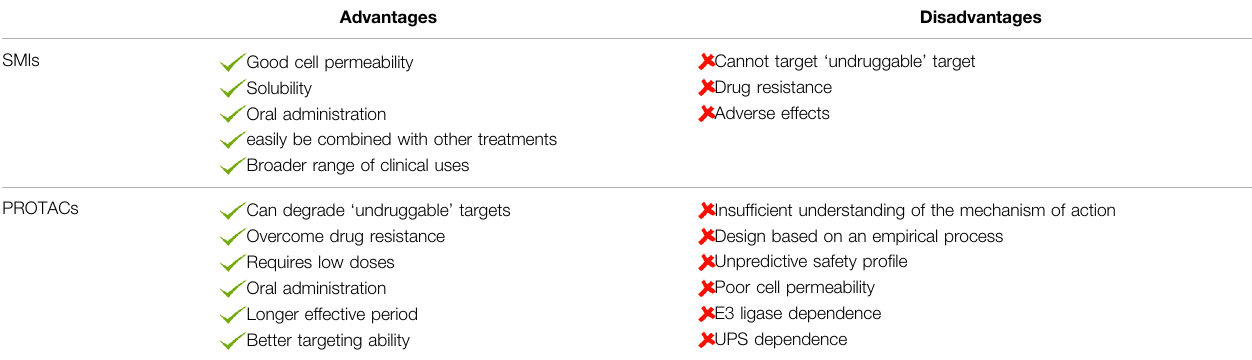
TABLE 1 | Advantages and disadvantages of PROTACs versus